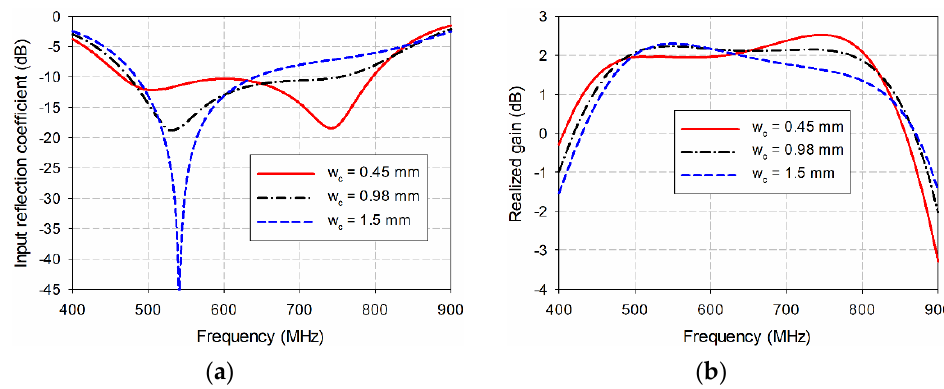
Figure 7. Effects of varying w c on the performance of the proposed antenna: ( a ) the input reflection coefficients, ( b ) the realized gain.